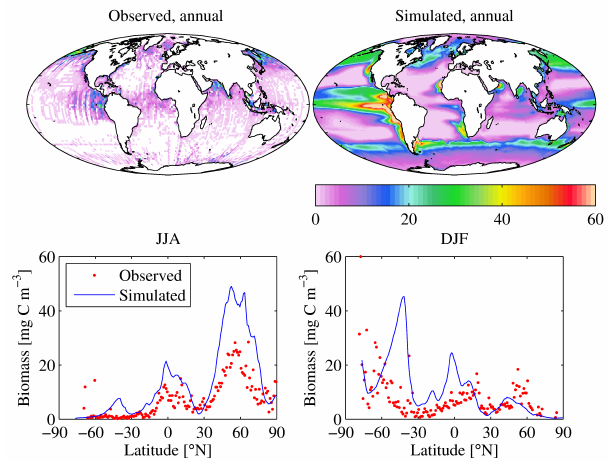
Fig. 35. Simulated slow (left) and fast (right) detrital sinking fluxes Fig. 30. Simulated slow ( left )and fast ( right ) detritalsinking fluxes at 100 m for northern summer (June–July–August; Fig. 30. Simulated slow ( left )and fast ( right ) detritalsinking fluxes at 100 m for northern summer (June–July–August; top ) and northern winter (December–January–February; bottom ). Detritus production in mmol N m − 2 d − 1 . at 100m for northern summer (June-July-August; top) and northern Fig. 33. Global, annual average observed (top left) and simu- top ) and northern winter (December–January–February; bottom ). Detritus production in mmol N m − 2 d − 1 . winter (December-January-February; bottom). Detritus production lated (top right) surface mesozooplankton, and zonal average north- in mmolNm − 2 d − 1 ern summer (June-July-August; bottom left) and northern win- ter (December-January-February; bottom right) surface mesozoo- plankton concentrations. Observations drawn from the COPEPOD database (O’Brien, 2005). Concentrations in mgCm − 3 .